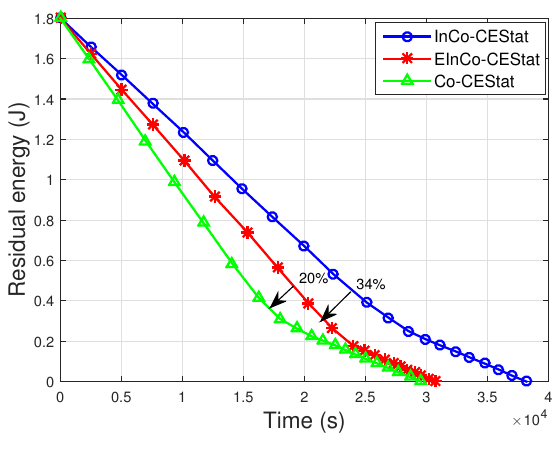
Figure 9. Residual energy of the network.